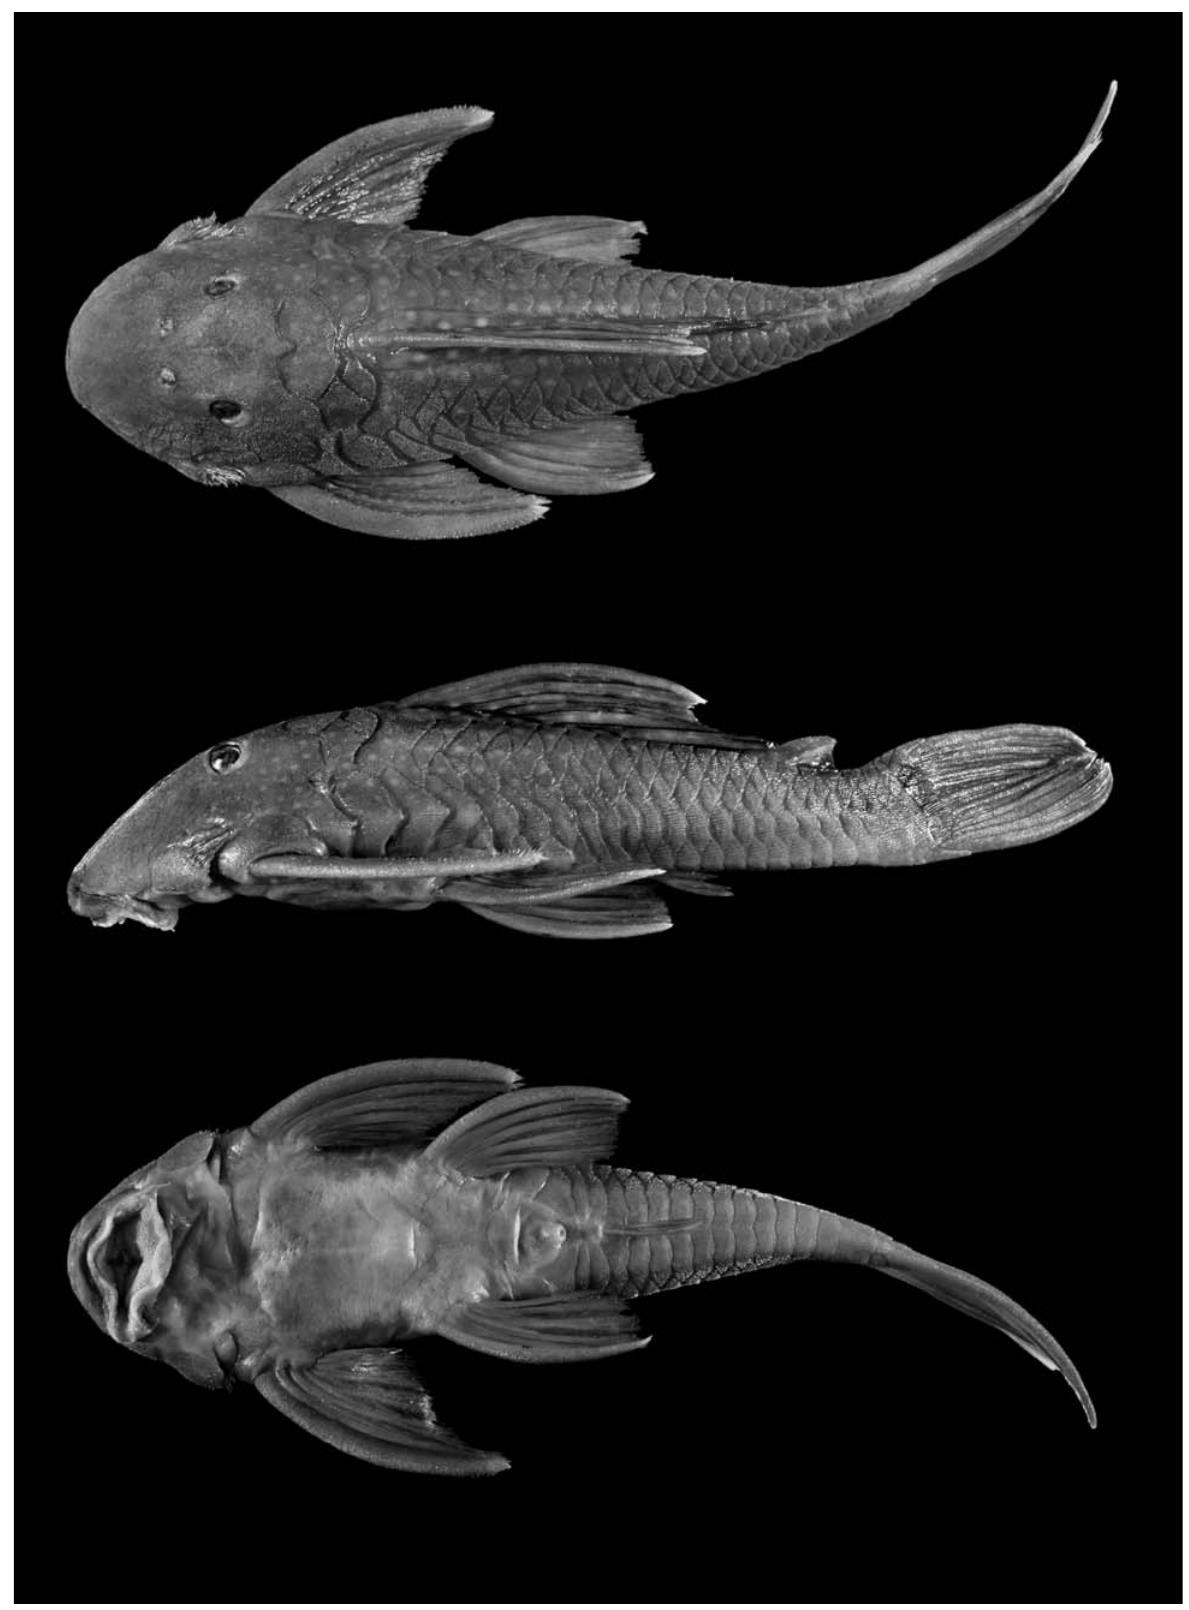
Fig. 2. Baryancistrus demantoides MCNG 54029, 150.5 mm SL; holotype, dorsal, lateral, and ventral views. Photos by D.C.